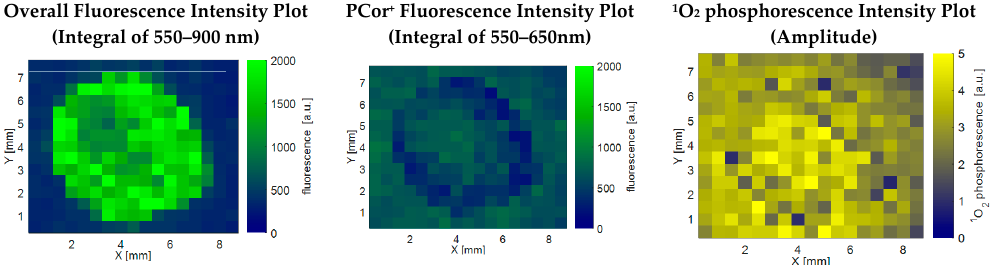
Figure 3. Comparison of the fluorescence intensity plots integrated over the whole recorded spectrum and the for the PCor + fluorescence relevant part of the recorded spectrum and the 1 O 2 phosphorescence intensity plot for a PCor + -algae sample. In contrast to TMPyP, PCor + appears to diffuse in the surrounding filter paper.